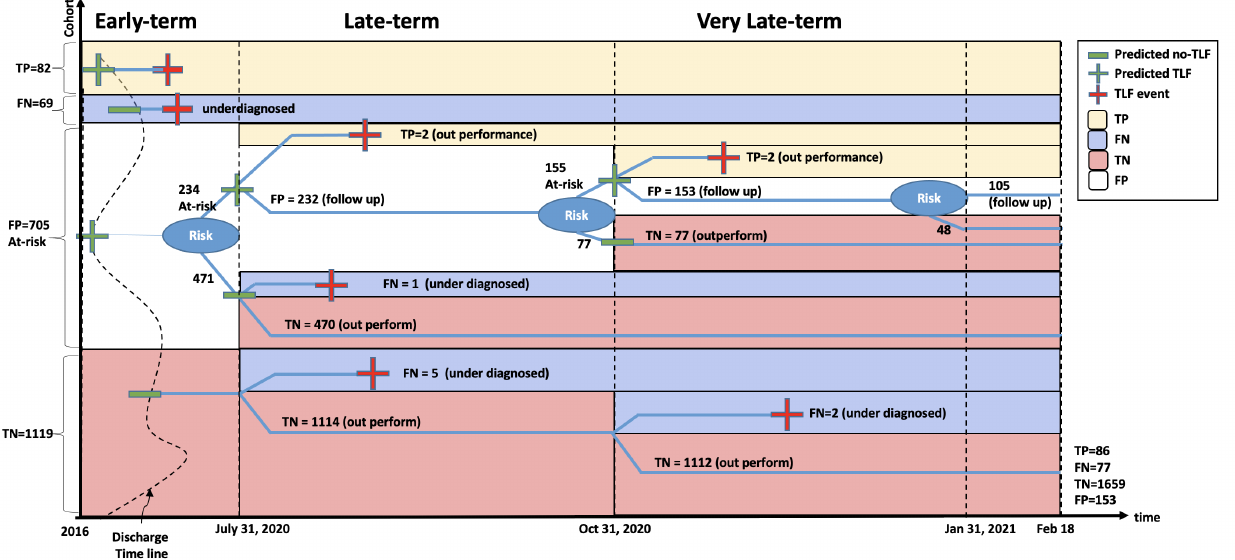
Figure 5. Retrospective and prospective validation of our TLF prediction